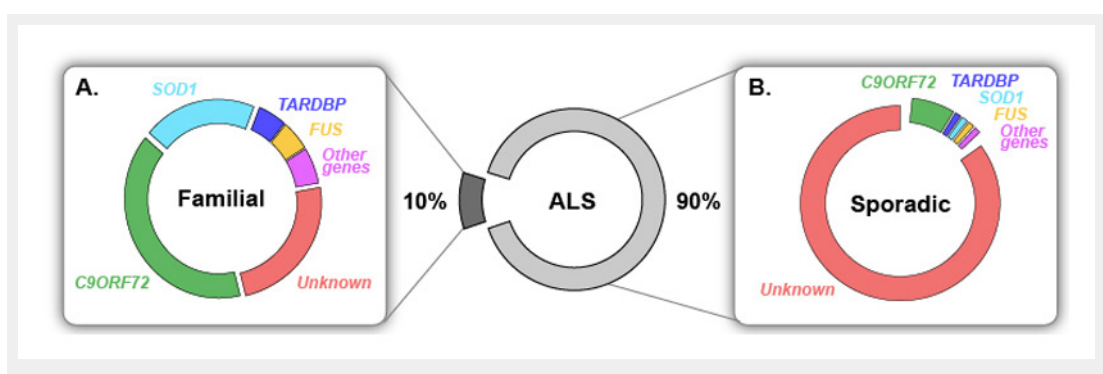
Known genetic causes in familial and sporadic ALS. Most ALS cases are sporadic (sALS) and only 10% are inherited, called familial (fALS). (A) 20% of fALS are caused by mutations in SOD1, which is the first known ALS-linked gene, identified in 1993. Mutations in the RNA/DNA-binding proteins TDP-43 and FUS cause a small fraction (~5%) of fALS each. Hexanucleotide repeat expansions in C9ORF72 are the most common genetic cause of ALS accounting for almost 40% of fALS in people of European ancestry. Several other genes have been identified as genetic causes of ALS and collectively today over 60% of fALS can be explained by known mutations. (B) While the aetiology of the vast majority of sALS remains unknown, mutations in genes known to cause fALS were identified in a small fraction of apparently sporadic patients. Most strikingly, hexanucleotide repeat expansions in C9ORF72 are causing approximately 7% of sALS without familial history in people of European